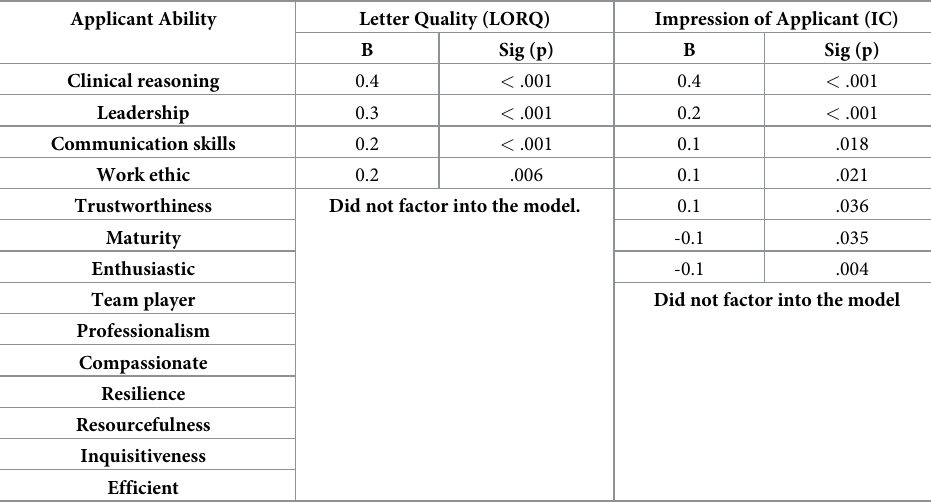
Table 2. Linear regression modelling of applicant abilities predicting LORQ and IC.